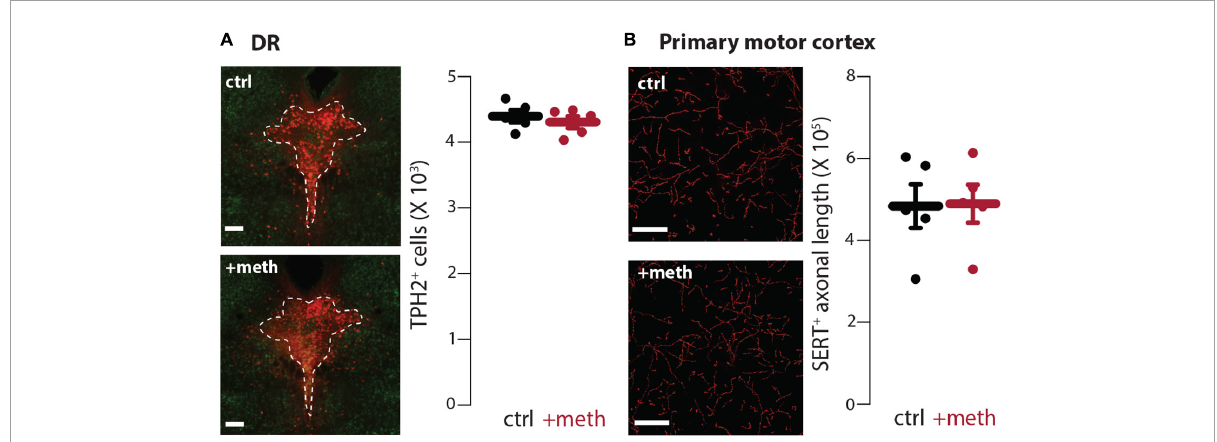
FIGURE4 Dorsal raphe (DR) neurons were resistant to chronic meth-induced degeneration. (A) Sample images (left) depicting tryptophan hydroxylase expressing (TPH2 + ) neurons in DR of saline (ctrl; 10 ml/kg)-and meth (+meth; 5 mg/kg)-treated mice; scale bars denote 200 µ m; TPH stained in red with NeuN counterstained in green. Quantified data (right) indicate that chronic meth had no effect on number of TPH2 + cells in the DR; ctrl n = 5 and +meth n = 5 mice. Data analyzed using an unpaired t -test [ t ( 8 ) = 0.6708, p = 0.5212, two-tailed]. (B) Sample images (left) depicting SERT + axons in the primary motor cortex of ctrl and +meth mice; scale bars denote 20 µ m. Quantified data (right) show no difference in axon length between ctrl and +meth mice; ctrl n = 5 and +meth n = 5 mice. Data analyzed using an unpaired t -test [ t ( 8 ) = 0.07813, p = 0.9396, two-tailed].